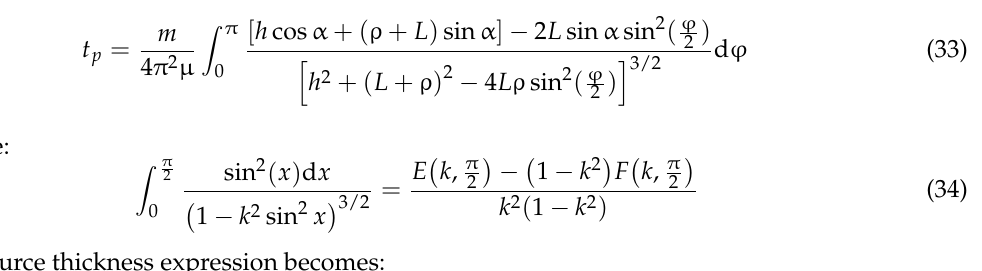
Figure 17. Relative film thickness distribution at different Y 1 positions.